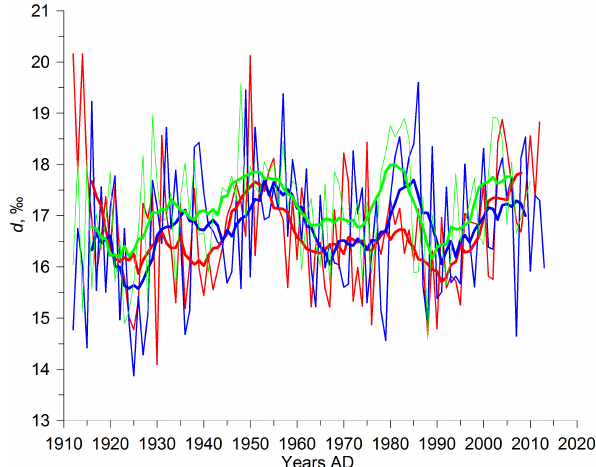
Figure 6. Annual variations in deuterium excess in the warm season (red line), in the cold season (blue line), and mean annual values (green line). Thick lines show the 10-year smoothed values, and the thin ones display the raw